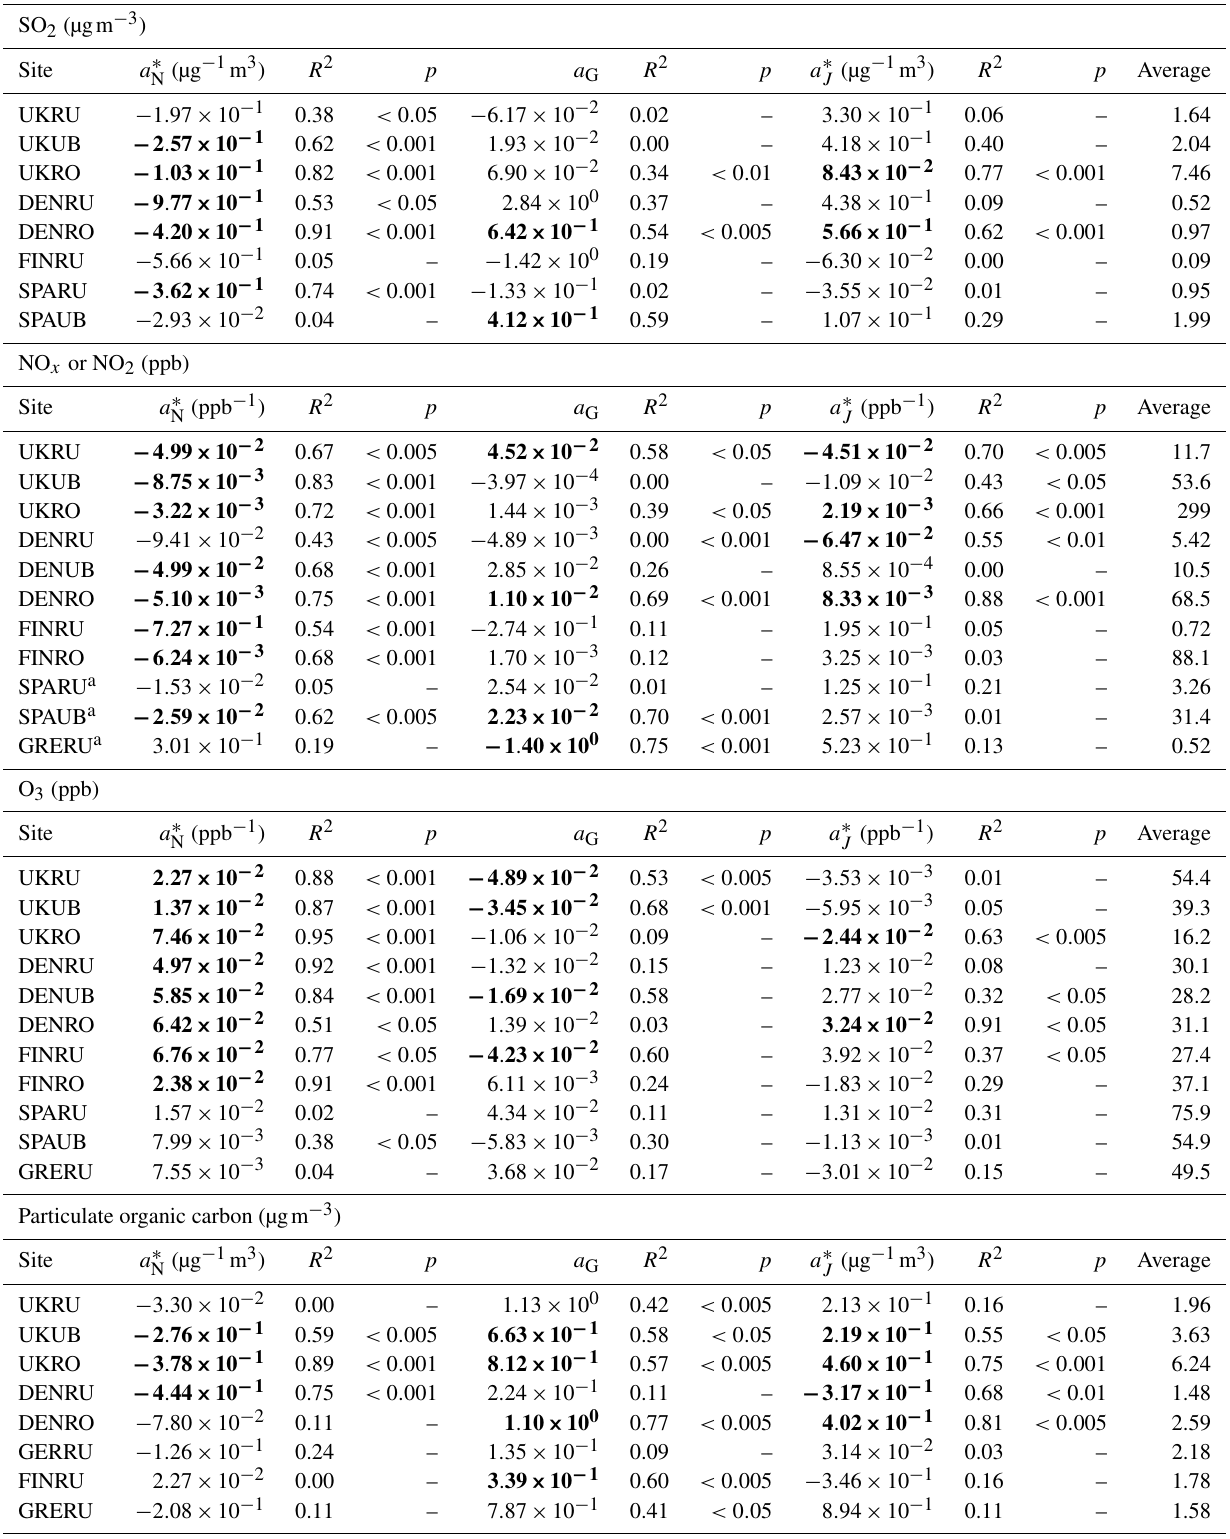
Table 4. Normalised gradients (non-normalised for growth rate), R 2 , and p values (– for values > 0 . 05) for the relation between atmospheric composition variables and NPF event variables. Gradients of R 2 > 0 . 50 are in bold. SO 2 (µgm − 3